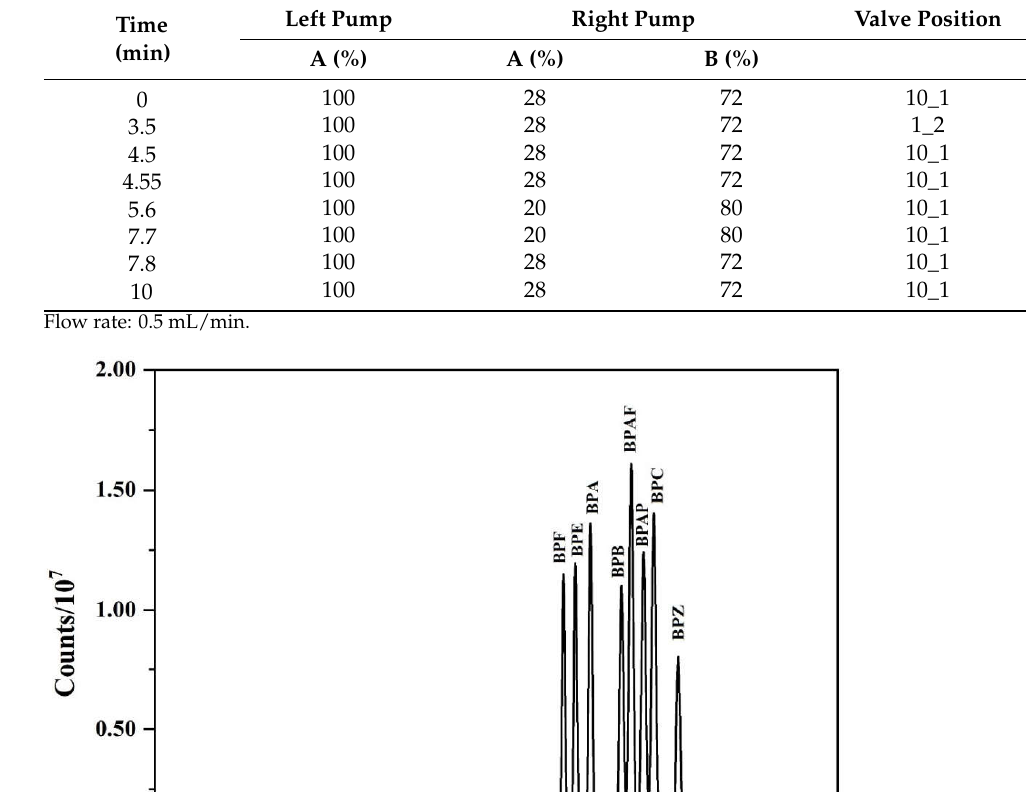
Table 1. The optimization procedure for on-line separation and enrichment of eight BPs.